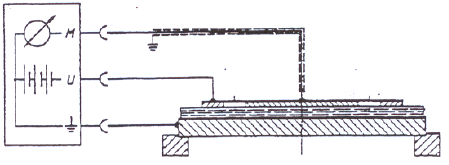
Figure 1. Measuring circuit of surface resistance measurement.